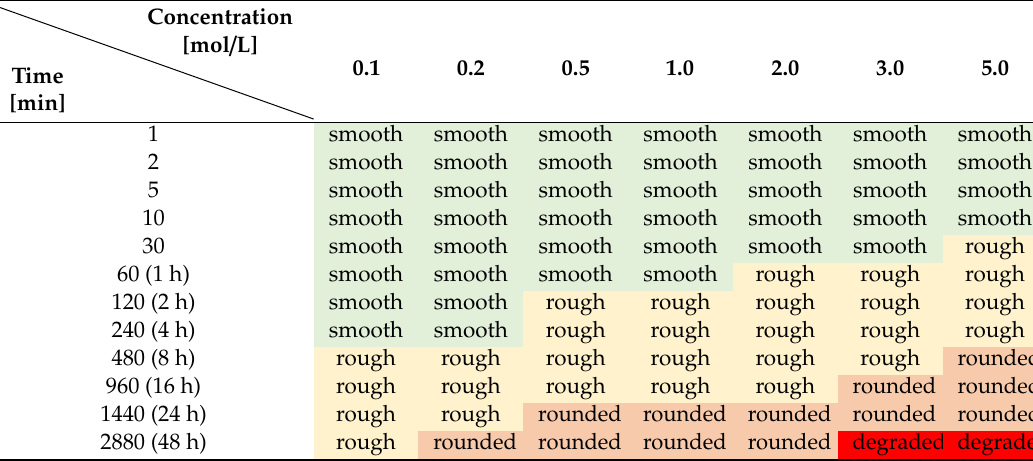
Table 1. Surface morphology of PLA sca ff olds treated with NaOH. The surface is qualitatively categorized as described above. “Degraded” refers to samples that are mostly dissolved and cannot be